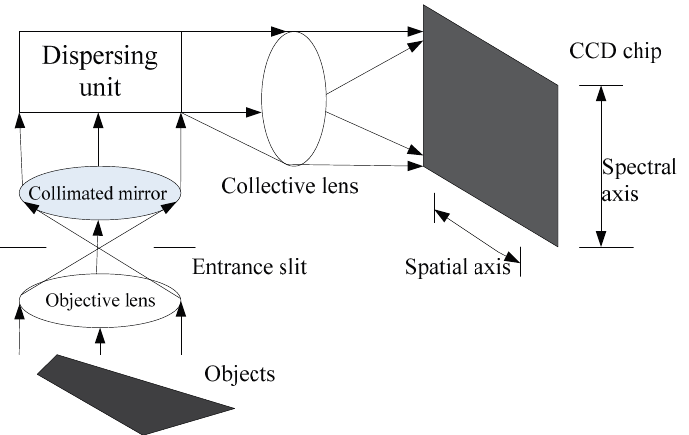
Figure 2. Basic principle of the FISS.